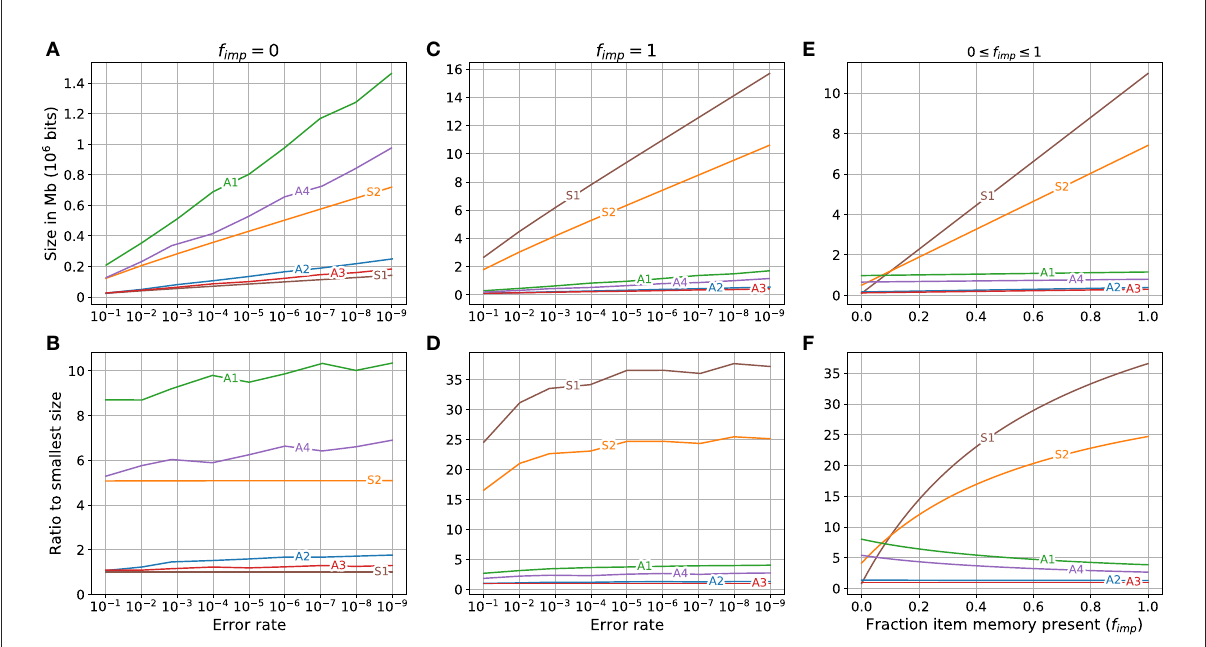
FIGURE4 Storage required for different memory variations when different fractions of fixed bits (item memory and SDM’s address memory) are present. (A, C, E) Top row shows the storage required. (B, D, F) Bottom row shows the ratio between the storage required by each variant and that used by the variant occupying minimal storage. Left column: fixed bits (item memory and SDM’s address memory) are not present ( f imp = 0). Middle column: fixed bits are fully present ( f imp = 1). Right column: Storage required for different memory variations for error rate of 10 − 6 when fraction of fixed bits present ranges from 0 to 1 (0 ≤ f imp ≤ 1).